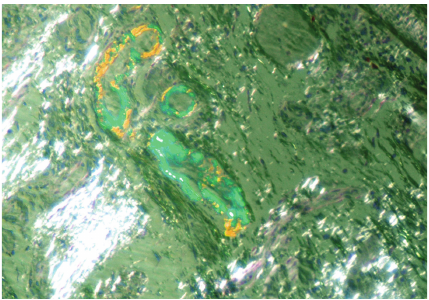
Figure 3: Perivascular amyloid deposit in colon submucosa (Congo red staining, with